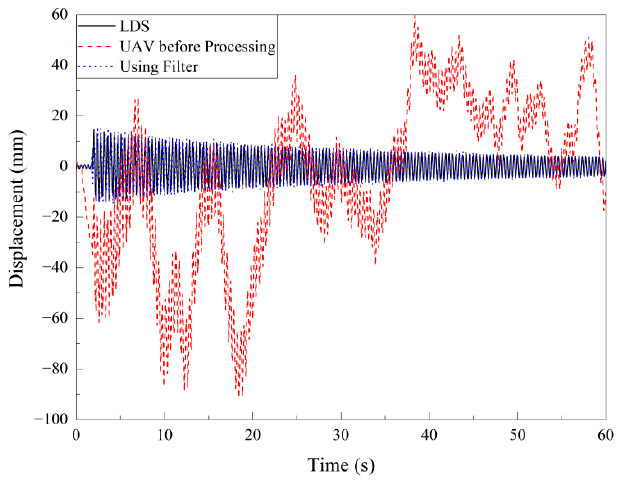
Figure 6. Comparison among the original UAV monitoring results, the processing UAV monitoring results and LDS monitoring results.